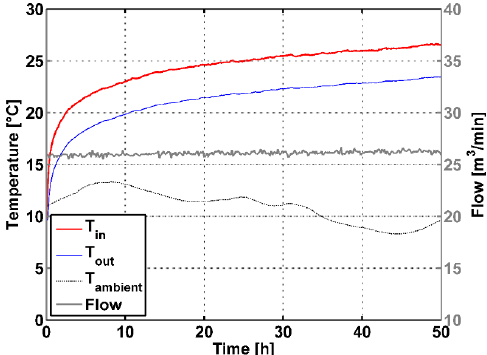
Figure 10. Thermal response testing (TRT) field data of a 100m-deep single U borehole heat exchanger (VIA 14), collected in Denmark [114].